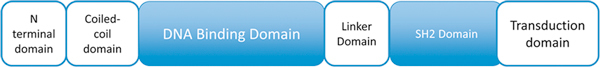
Organization of the STAT3 protein.